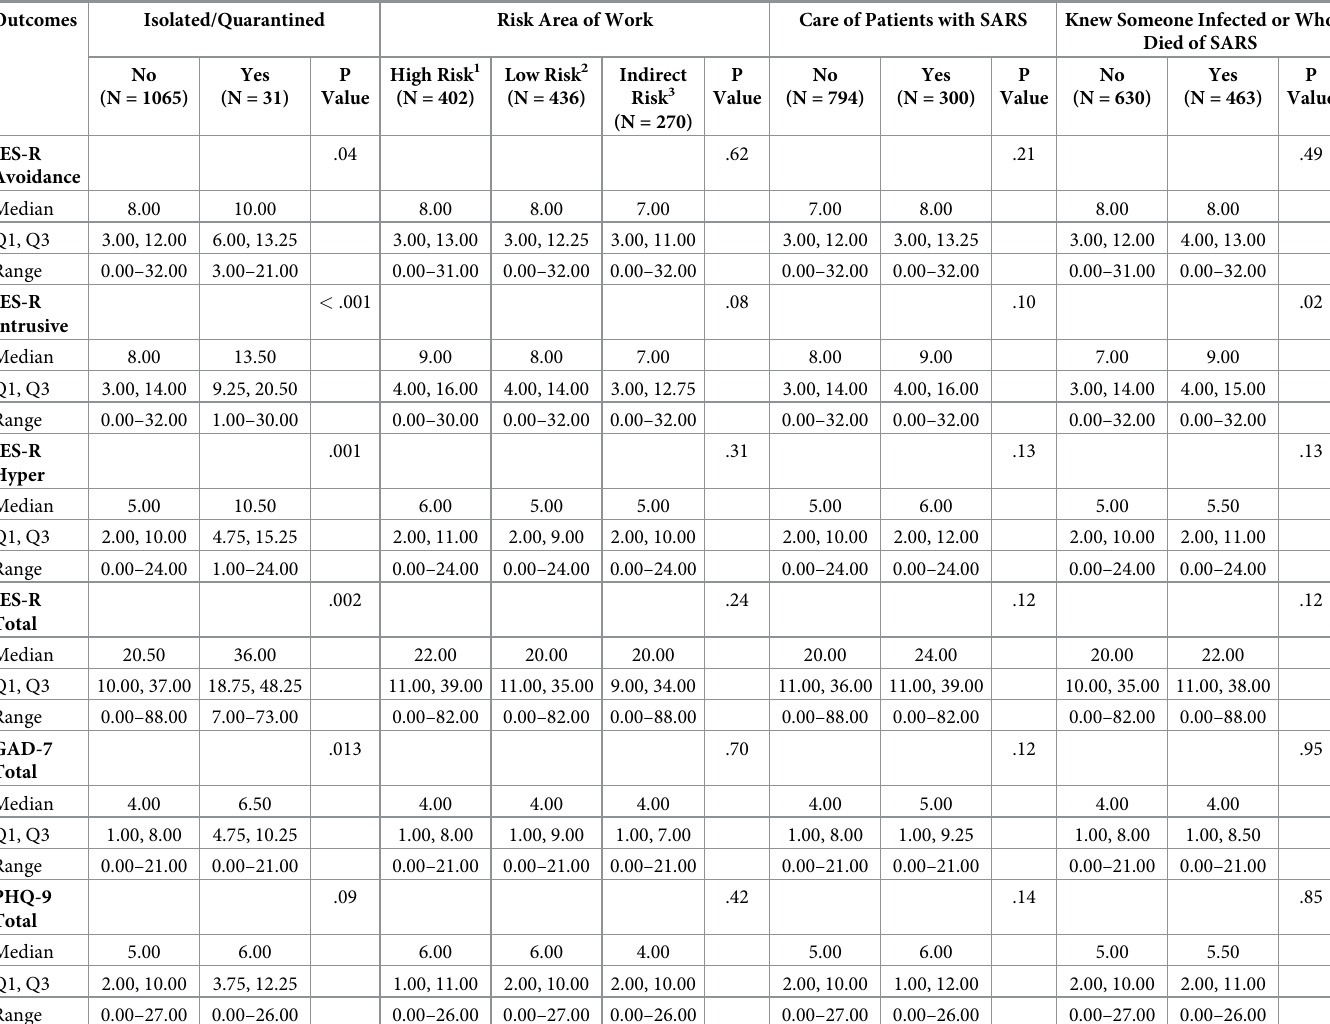
Table 4. Work experience during SARS and mental health outcomes in healthcare workers.